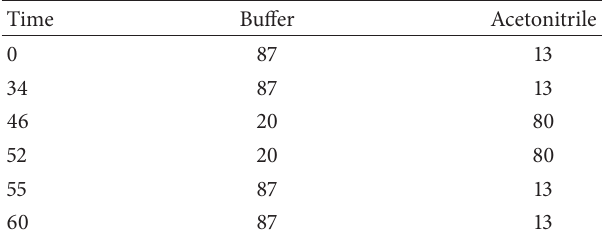
Table 1: Gradient